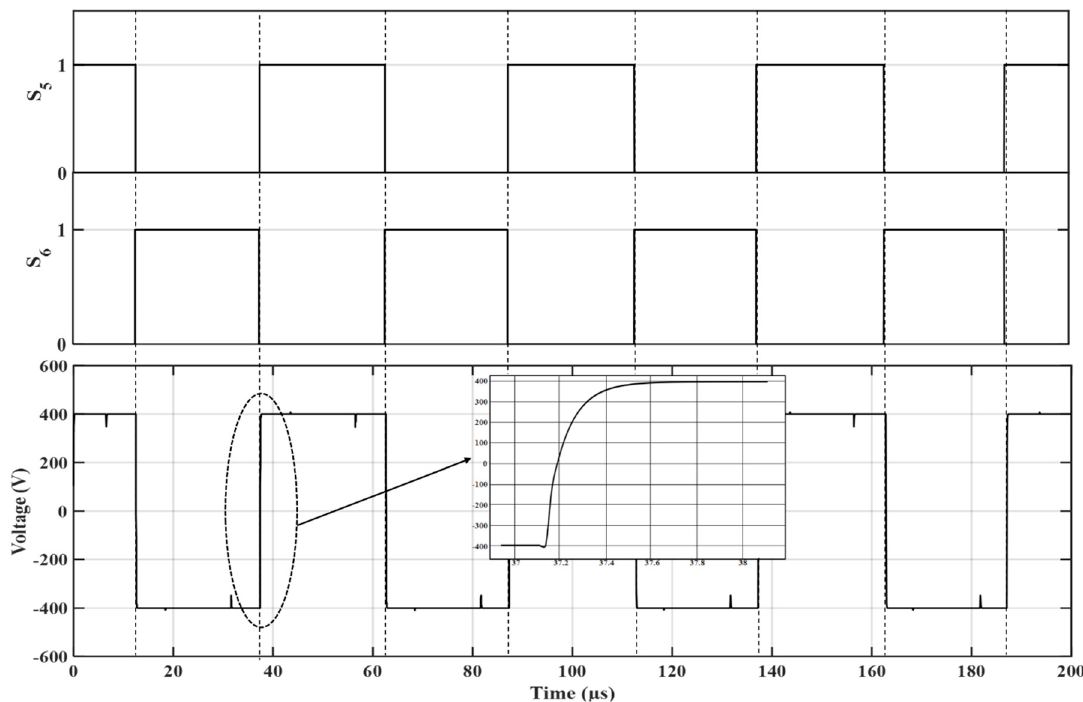
Figure 4. Switching patterns for voltage of phase-a for the pulse-width modulated converter.